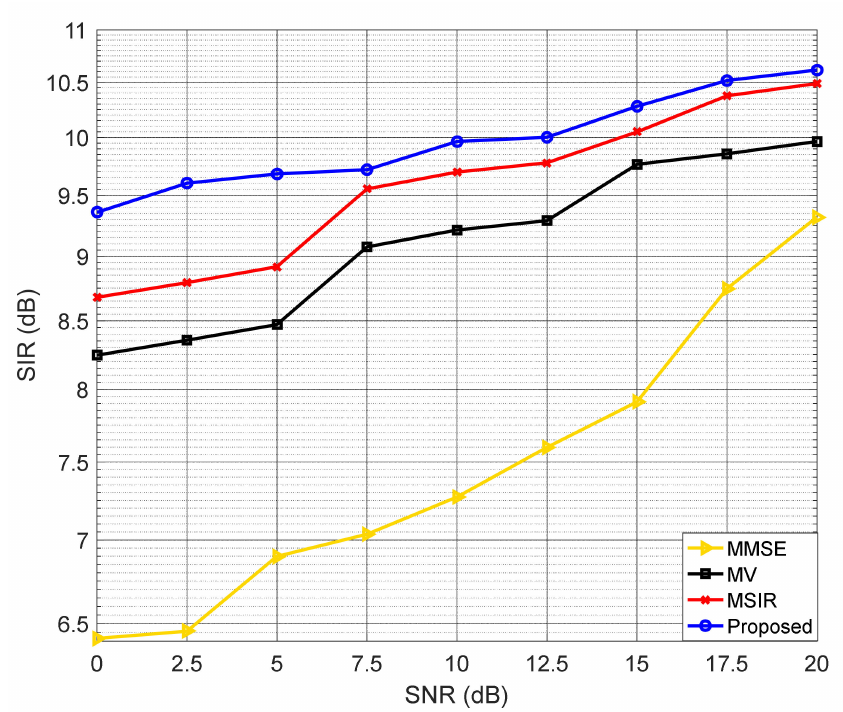
Figure 11. SIR comparison between the proposed method and three different